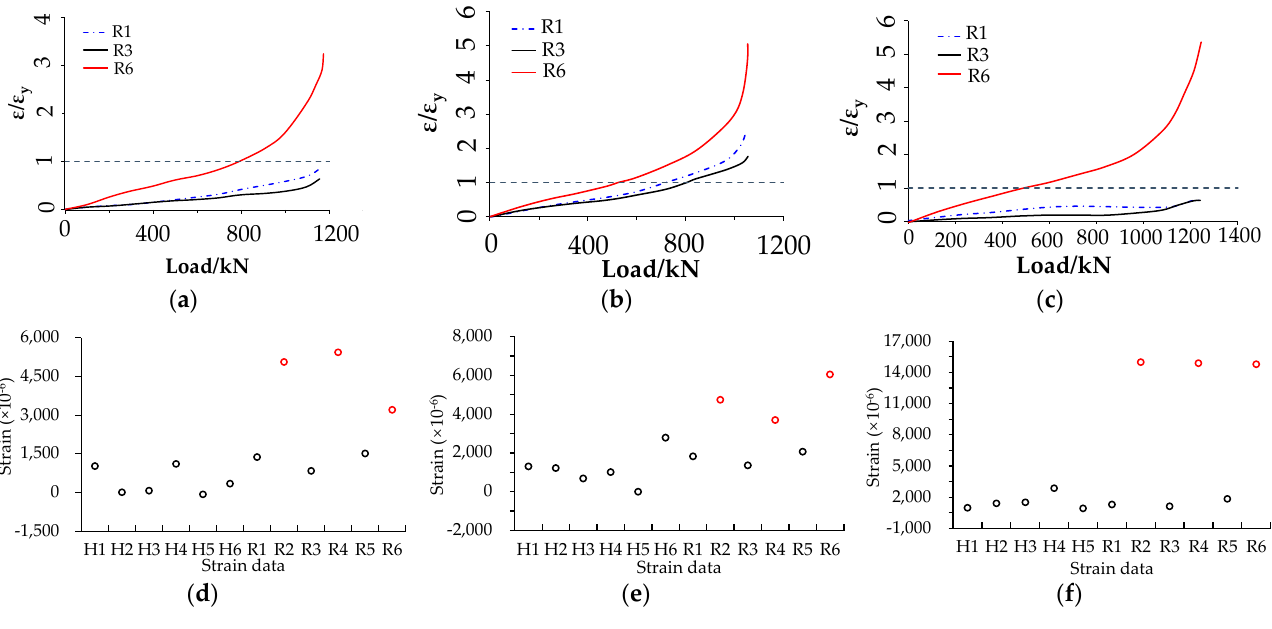
Figure 13. Strain gauge values obtained from the test: ( a ) strain-load curves of Specimen SC − 1; ( b ) strain-load curves of Specimen SC − 2; ( c ) strain-load curves of Specimen SC − 5; ( d ) strain data of Specimen SC − 1; ( e ) strain data of Specimen SC − 2; and ( f ) strain data of Specimen SC − 5.